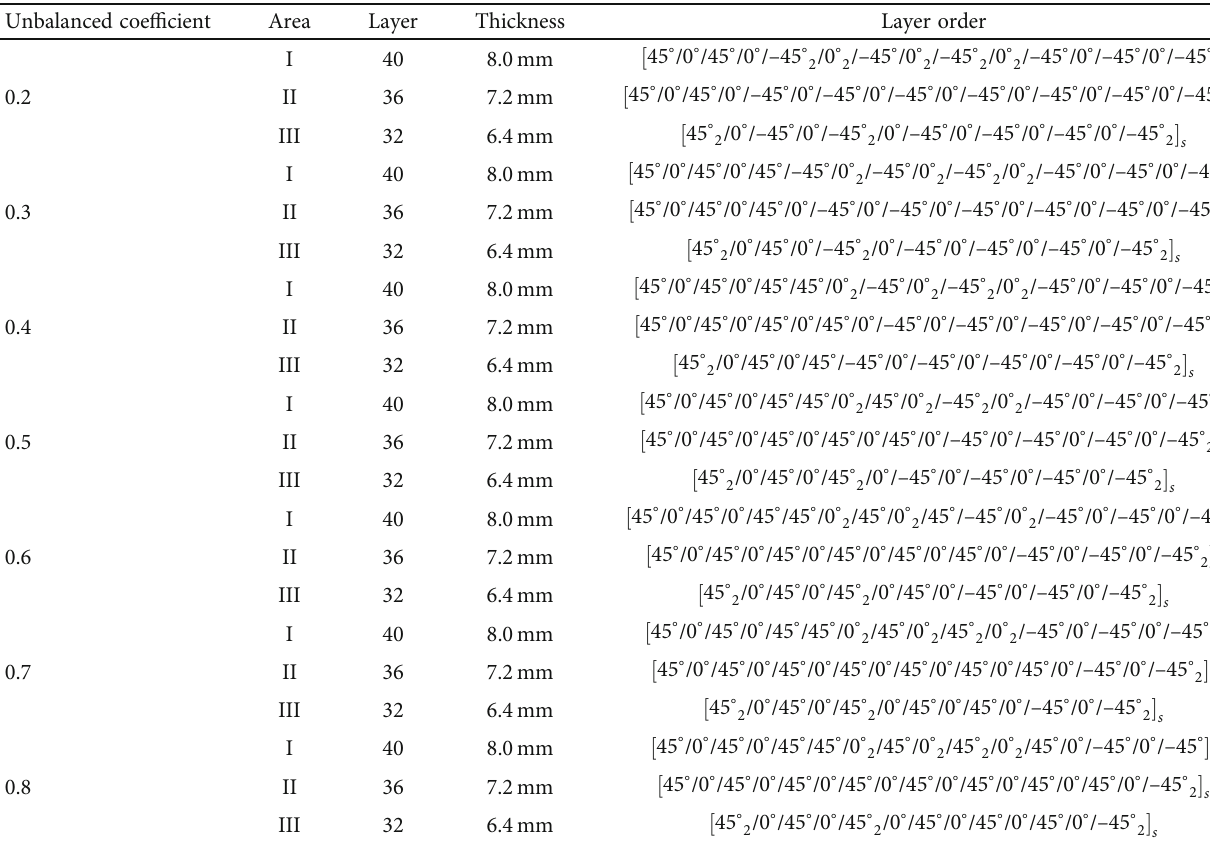
Table 4: Variable thickness layout scheme.